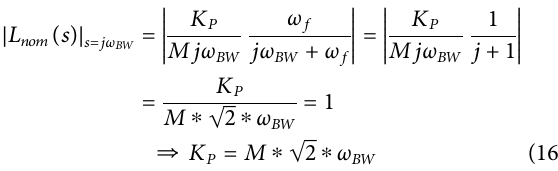
Frontiers in Robotics and AI |